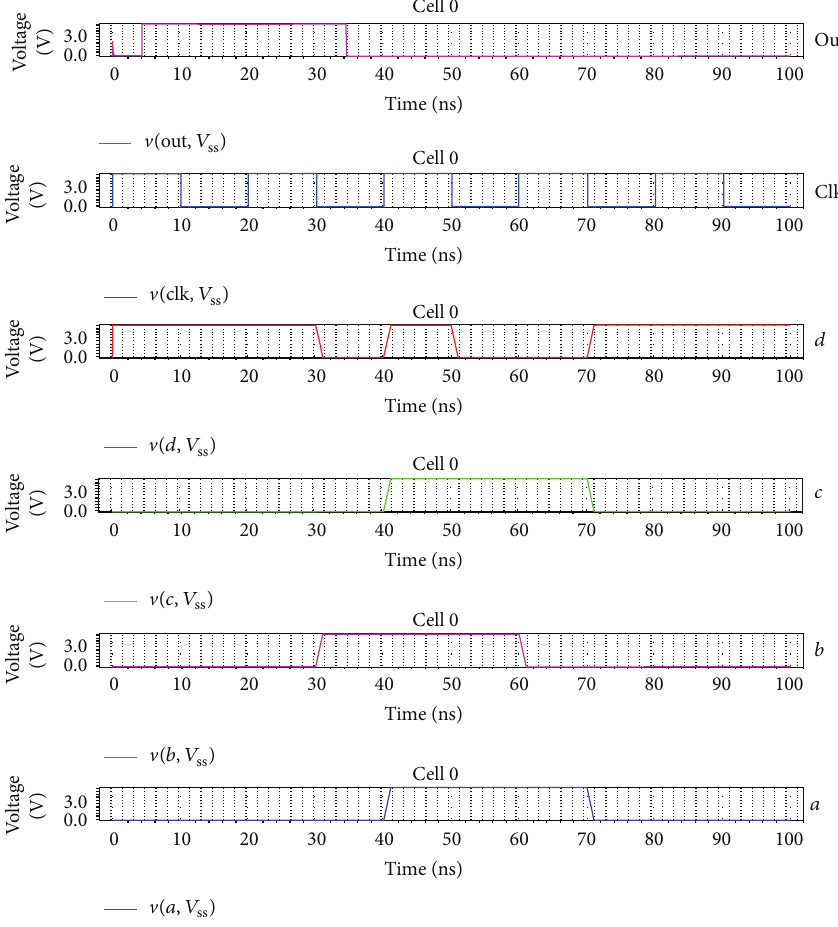
Figure 12: Output waveform of synchronous Viterbi